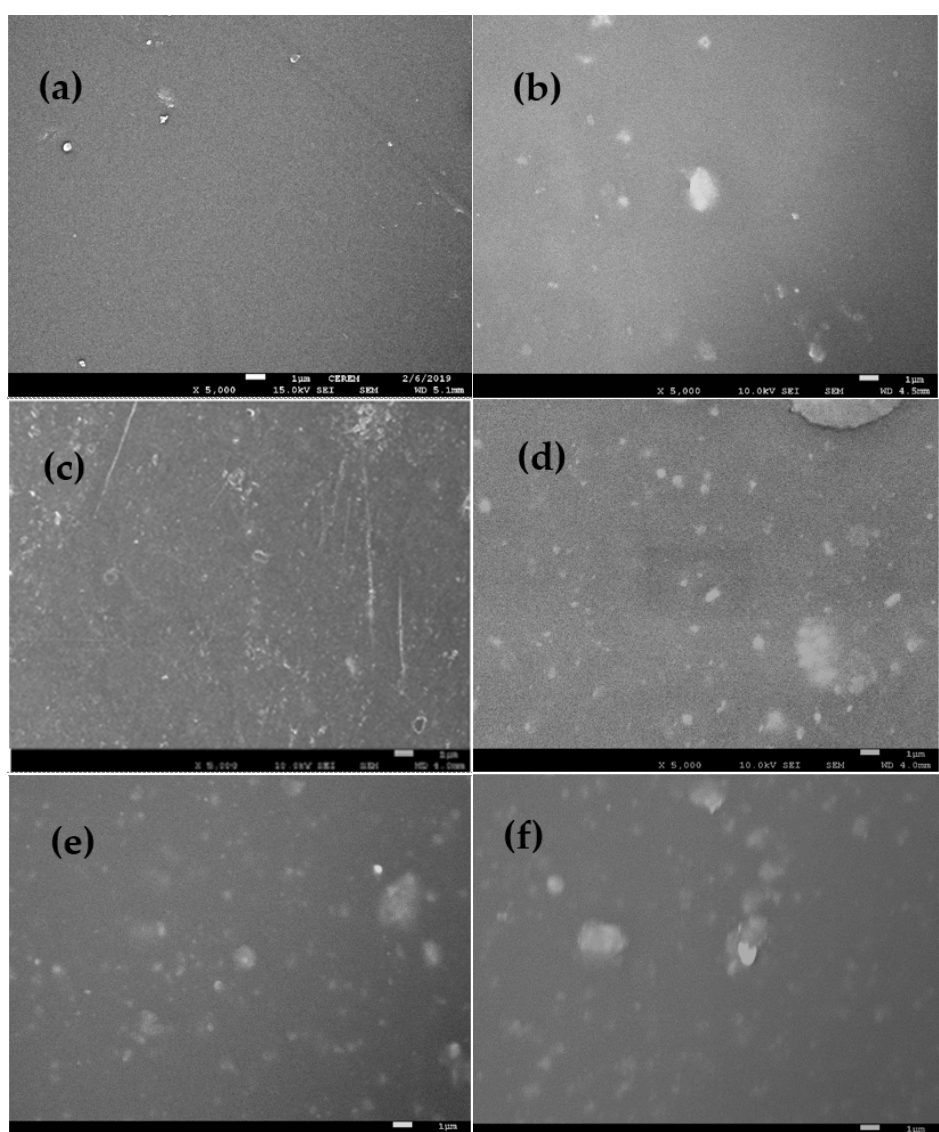
Figure 1. SEM images of ( a ) blank epoxy, ( b ) E51, ( c ) E52, ( d ) E53, ( e ) E54, and ( f ) E55.